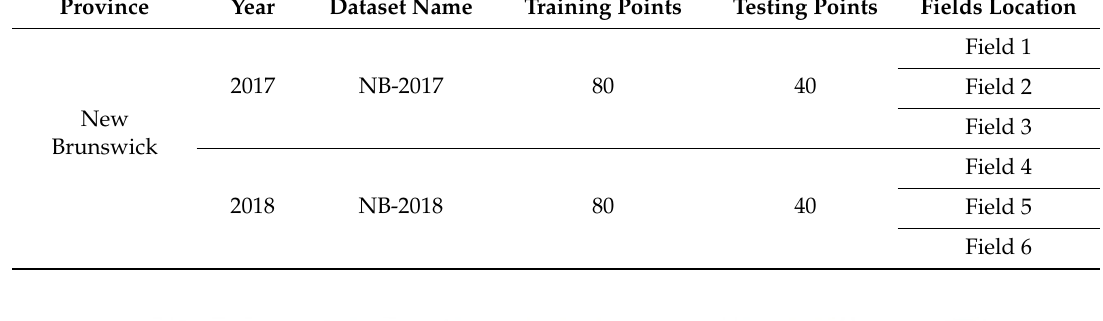
Table 1. Description of study sites, study years, datasets, the data used for training and testing of machine learning algorithms and potato fields used for data collection.